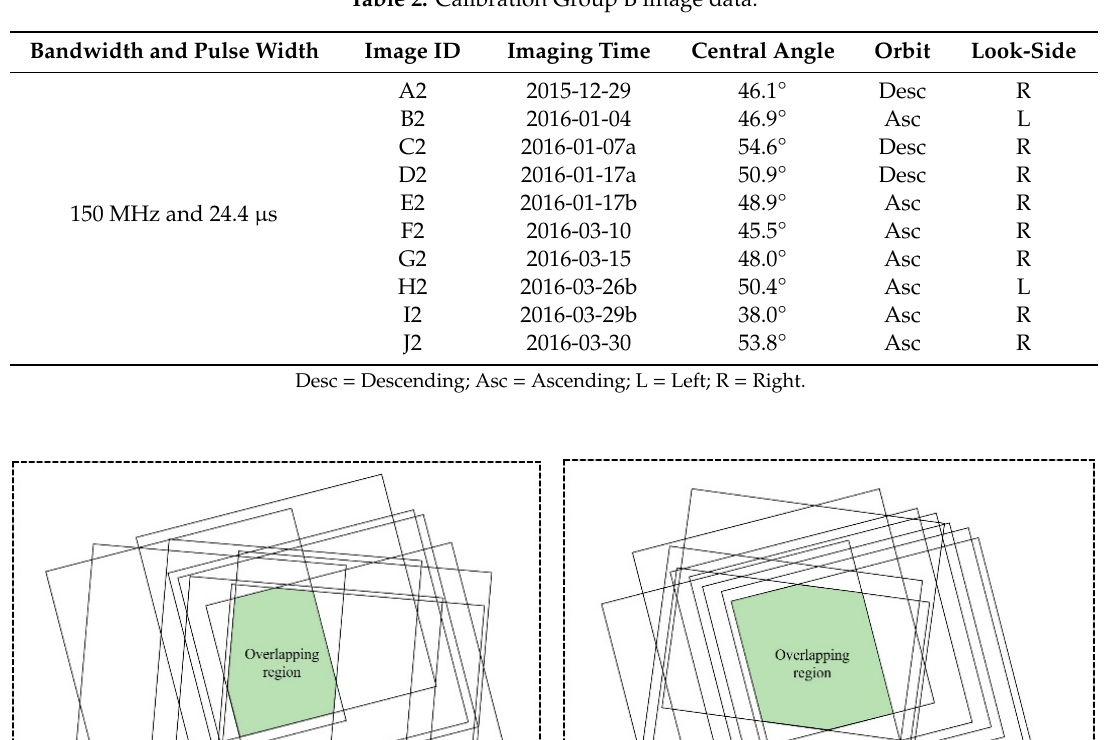
Table 3. Geometric calibration results for Calibration Group A (200 MHz and 24.4 μ s).